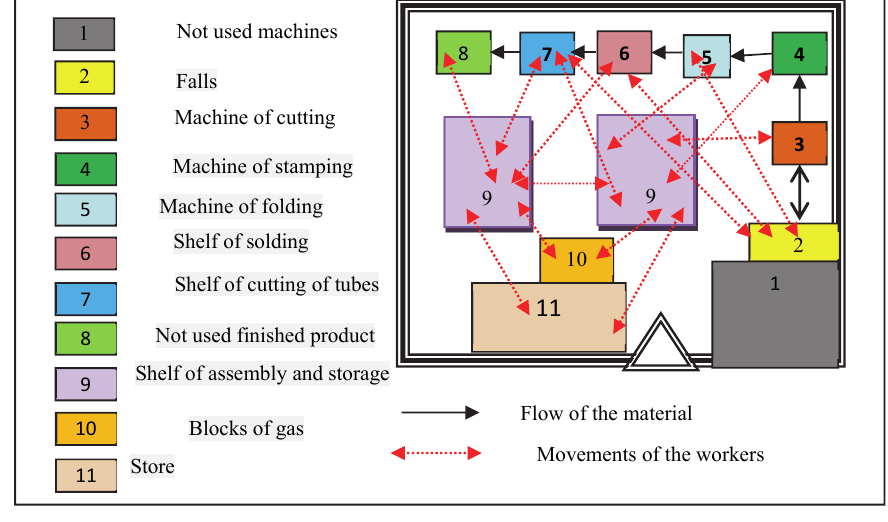
Fig. 4. Organization of the